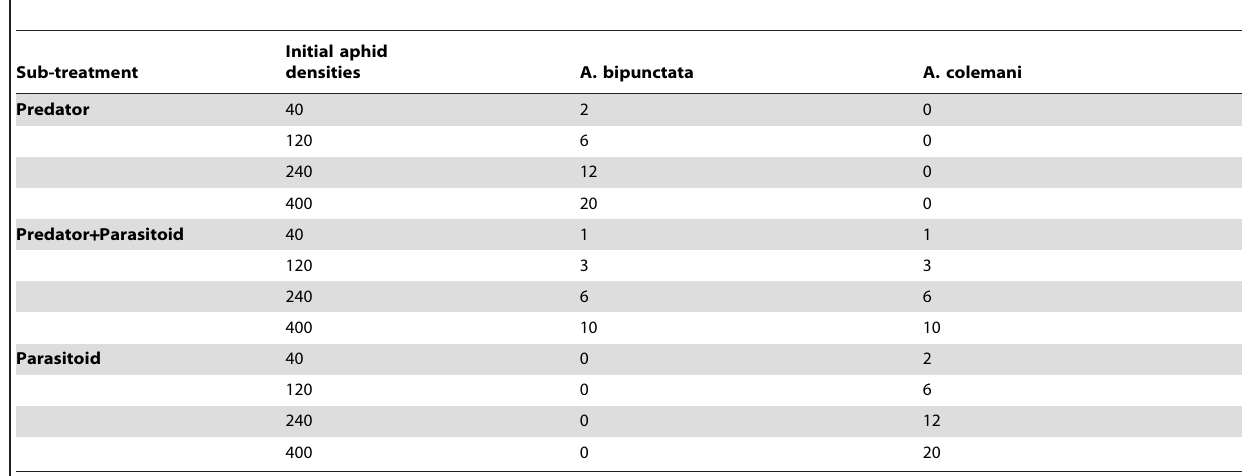
Table 1. Initial numbers of aphids, parasitoids ( Aphidius colemani ) and predators ( Adalia bipunctata ) used in the experiment.